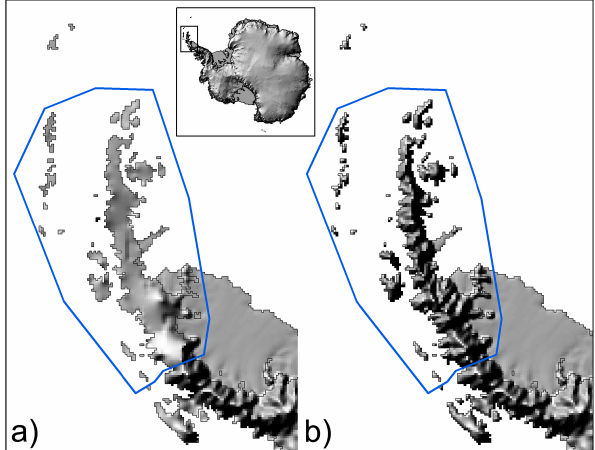
Figure 4. Ice surface join: (a) hillshade of JLB / JAG DEM and (b) hillshade of combined